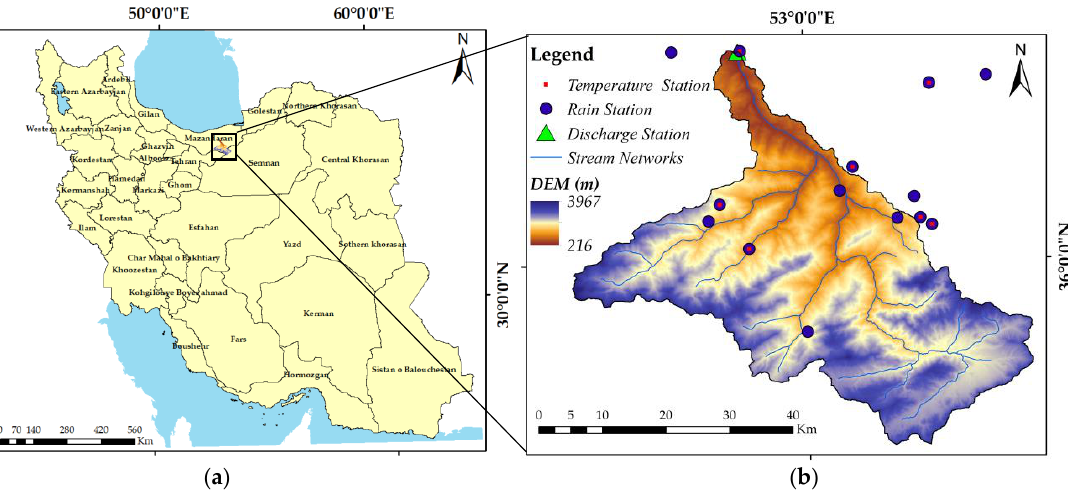
Figure 1. ( a ) Location of the Talar River Basin in northern Iran, ( b ) temperature, rainfall and discharge stations, and stream network.